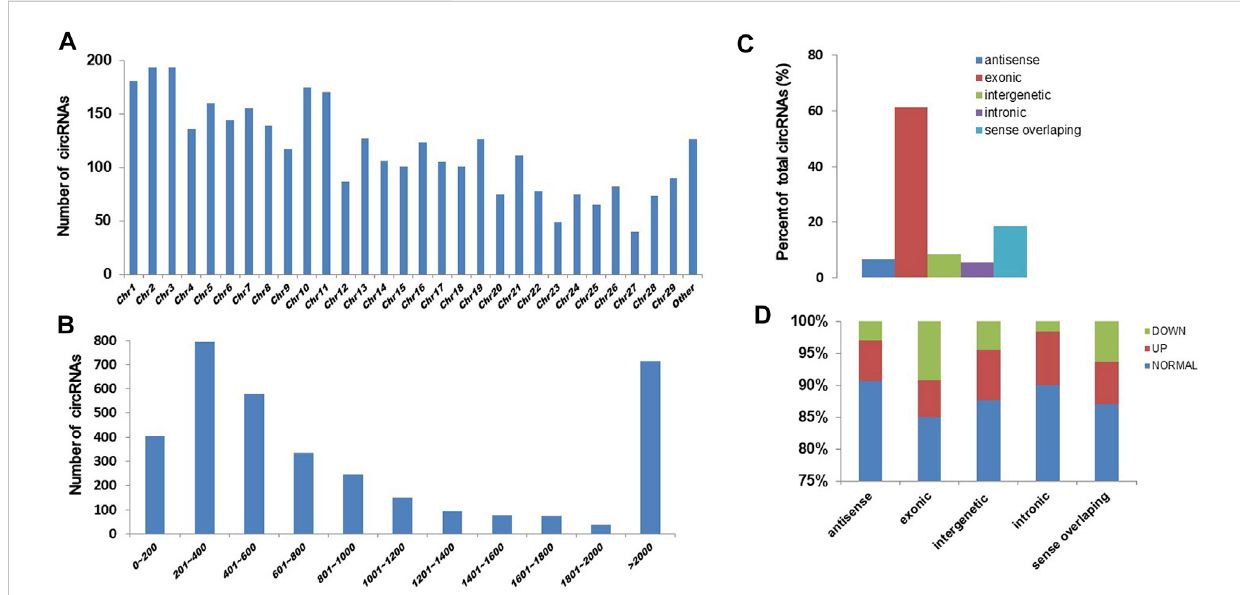
FIGURE 2 Expression pattern of circRNAs in the GO-AgNPs treated caprine fetal fi broblast cells (CFFCs). (A) Distribution of circRNAs on chromosomes. The x-axis represents the chromosome and the y-axis represents the number of circRNA. (B) The length distribution of total circRNAs. The x-axis represents the number of circRNAs and the y-axis represents the number of circRNA. (C) The genomic origin of the total circRNAs. (D) Percent of differentially expressed